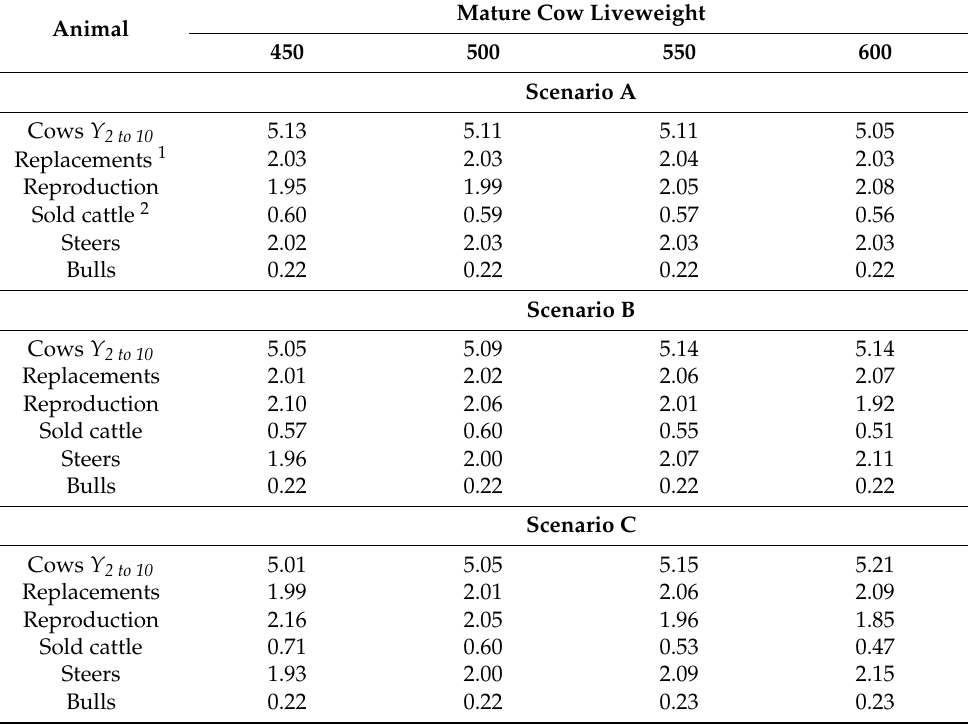
Table 5. Total annual feed demand (millions of megajoules of metabolisable energy) for cows (aged two to ten years), replacements (until two years of age), reproduction (gestation and lactation), sold youngstock, and bulls, with varying mature cow liveweight for scenarios with (A) a constant ratio of birth and weaning weights to mature cow liveweight, (B) decreasing ratios of birth and weaning weights to mature cow liveweight as mature cow liveweight increased, and (C) the ratio of birth weight to mature cow liveweight decreased with mature cow liveweight and constant pre-weaning growth rates of 1.00 kg/day. Mature Cow Liveweight Animal 450 500 550 600 Scenario A